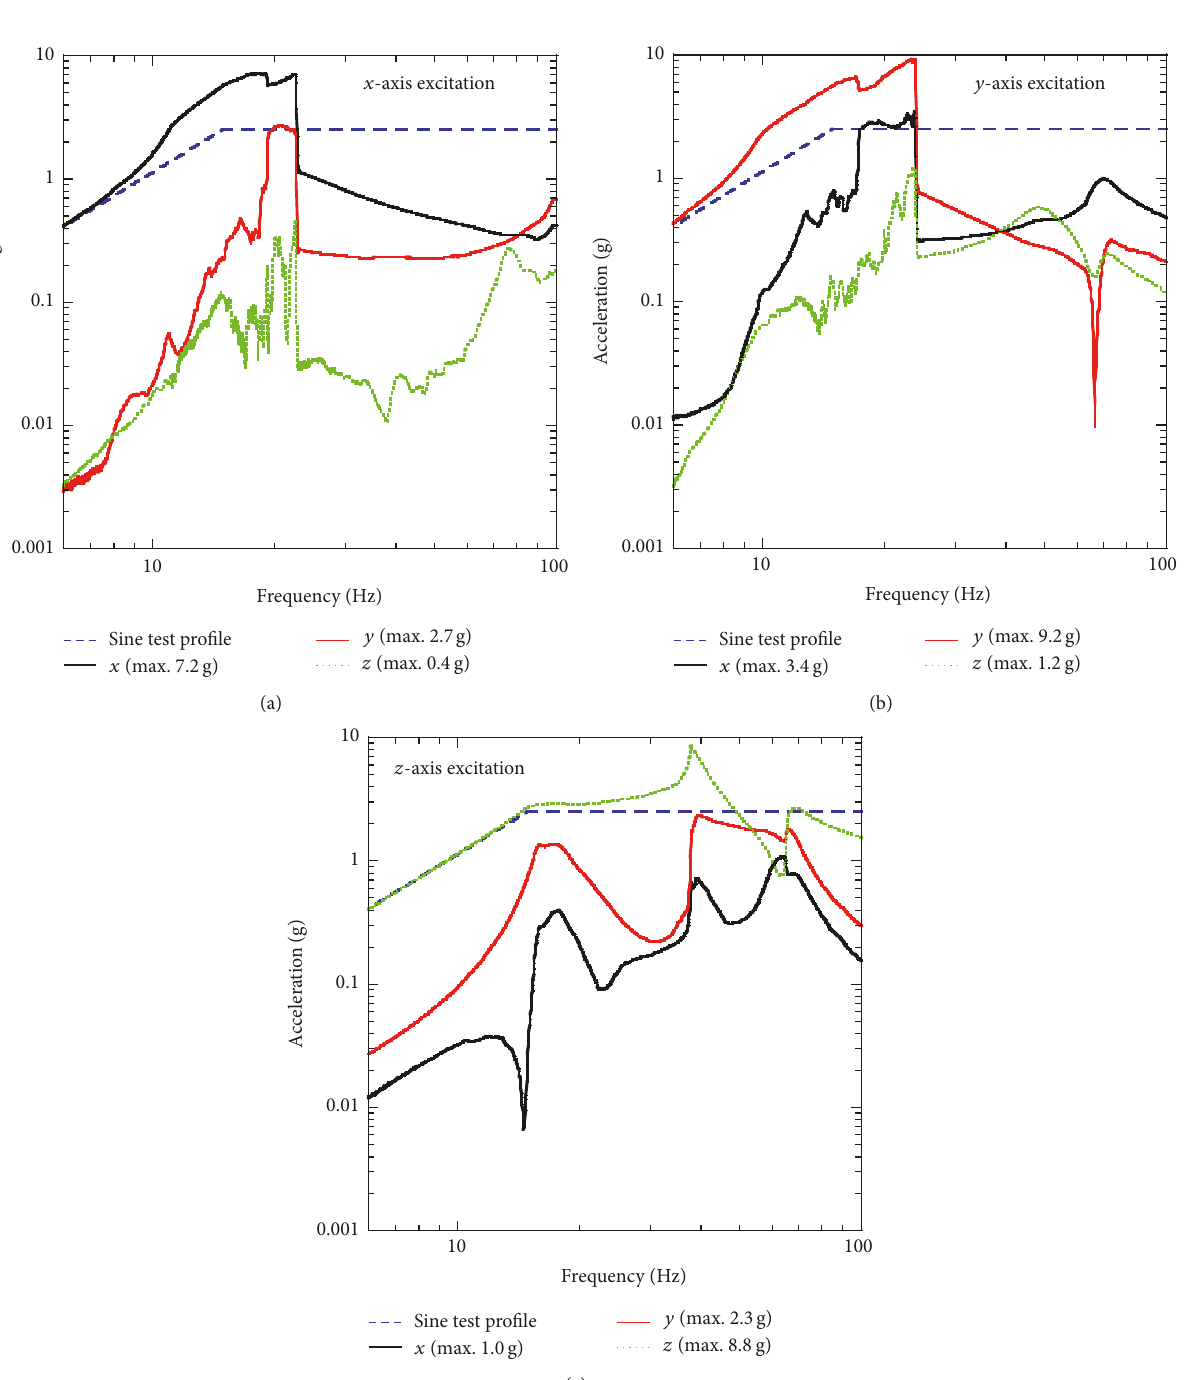
Figure 9: Results for sine vibration tests of the RWA isolation system with respect to each axis excitation ((a): 𝑥 -axis, (b): 𝑦 -axis, and (c): 𝑧